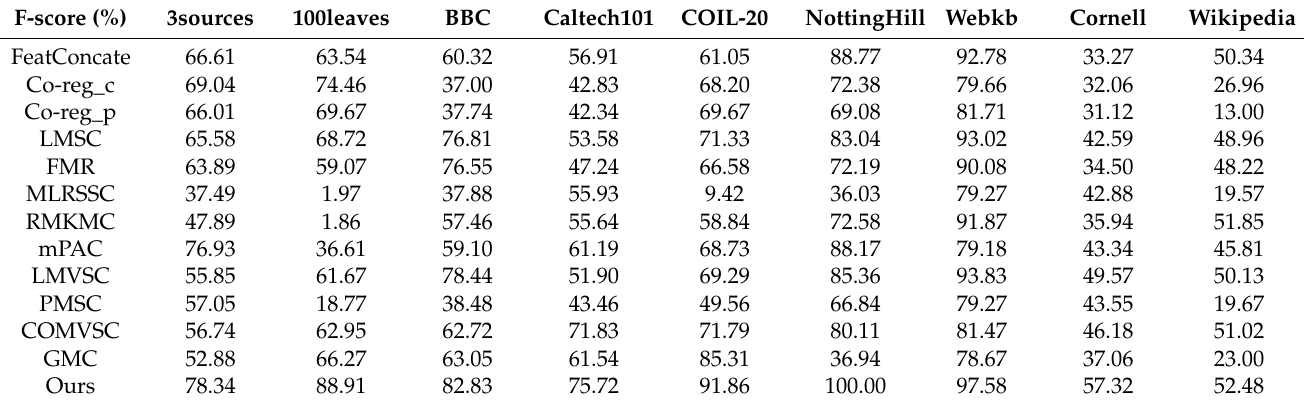
Table 5. The clustering performance comparison in terms of F-score on nine multi-view data sets.